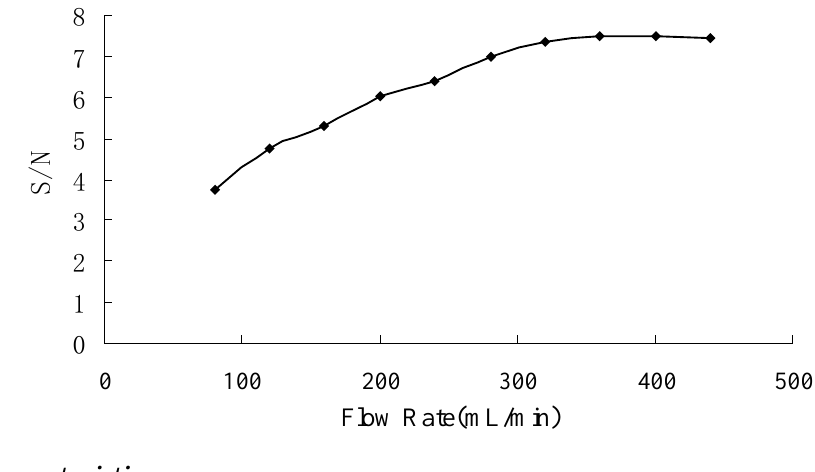
Figure 6. Effect of flow rate of carrier air on CTL intensity of benzene vapor (432°C, 425 nm, 4483 mL/m 3